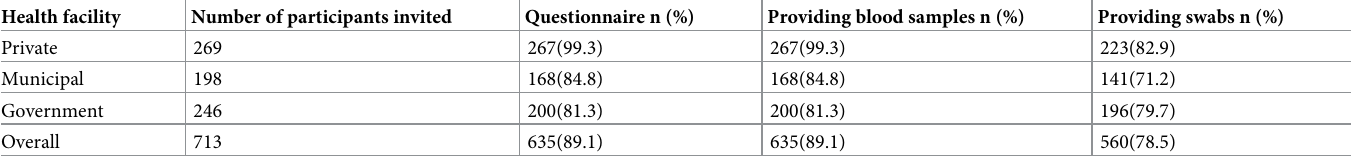
Table 1. Invited and consenting participants partitioned by type of health facility.